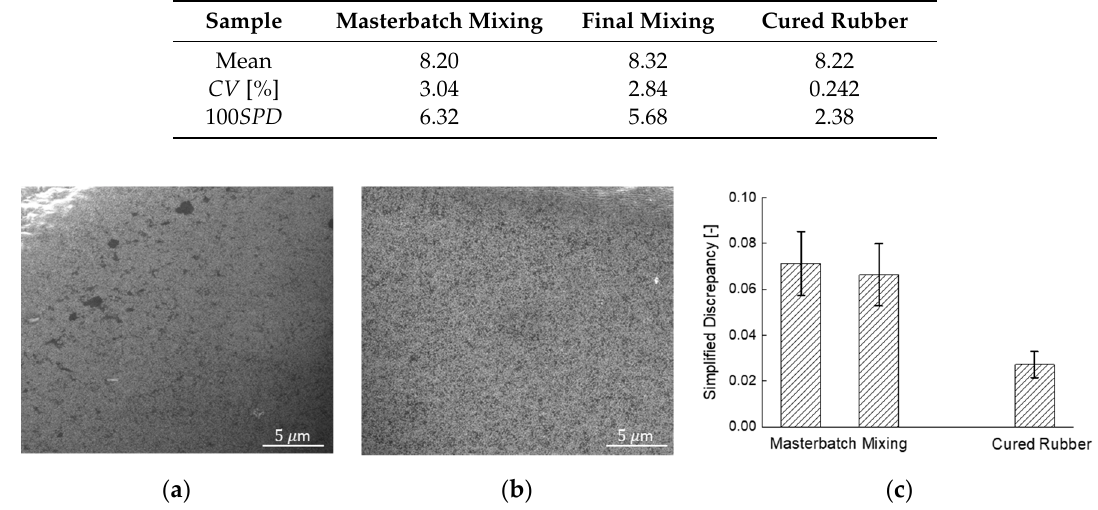
Figure 12. SEM image evaluation of SBR-based sample. ( a ) Silica masterbatch mixing, ( b ) vulcanized rubber, and ( c ) silica dispersion in SEM images derived by simplified discrepancy.